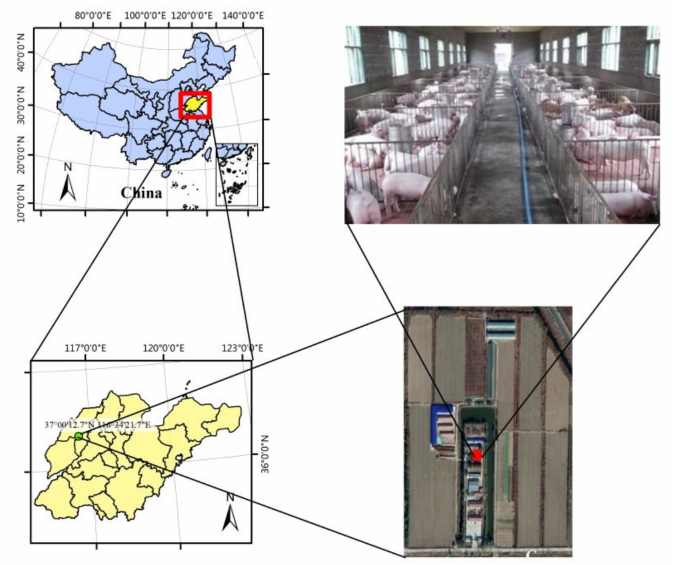
Figure 1. Location of the study area and the overview of ecological farm